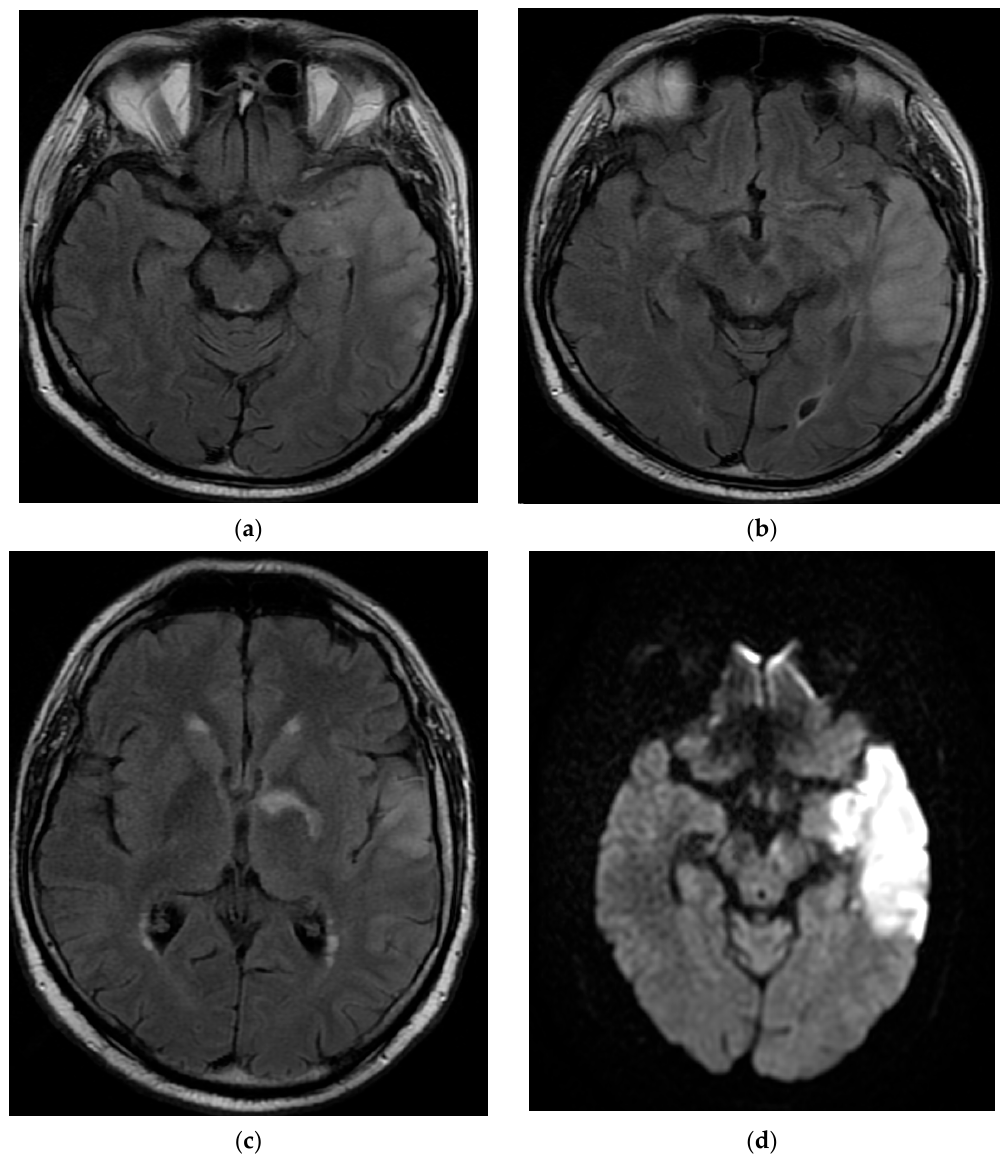
Figure 2. MRI brain images with contrast showed aspects of T2 axial Flair hypersignal in the left temporal lobe ( a , b ), respectively, in the hippocampal and parahippocampal region ( c ). The lesion is hyperintense on the DWI axial image ( d ). MRI: magnetic resonance imaging; Flair: fluid attenuated inversion recovery; DWI: diffusion weighted